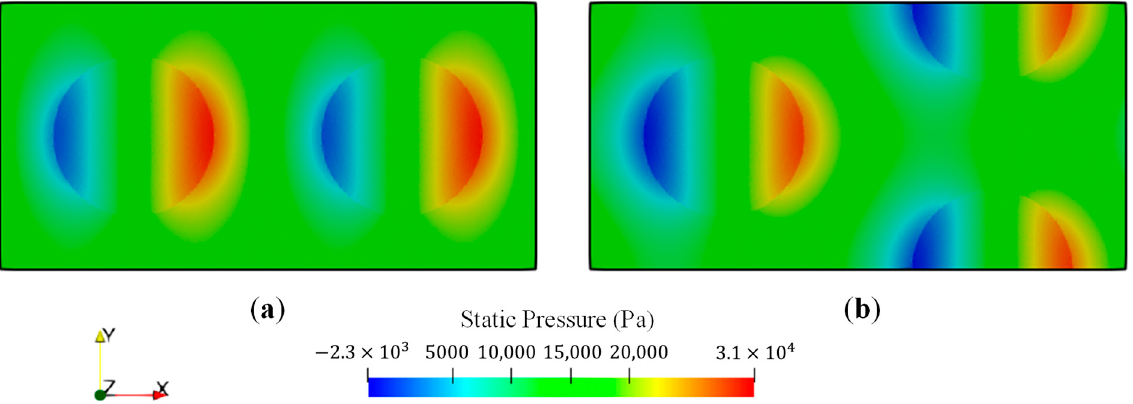
Figure 22. Static pressure distribution on the workpiece surface: ( a ) grid array pa tt ern; ( b ) crossing array pa tt ern.